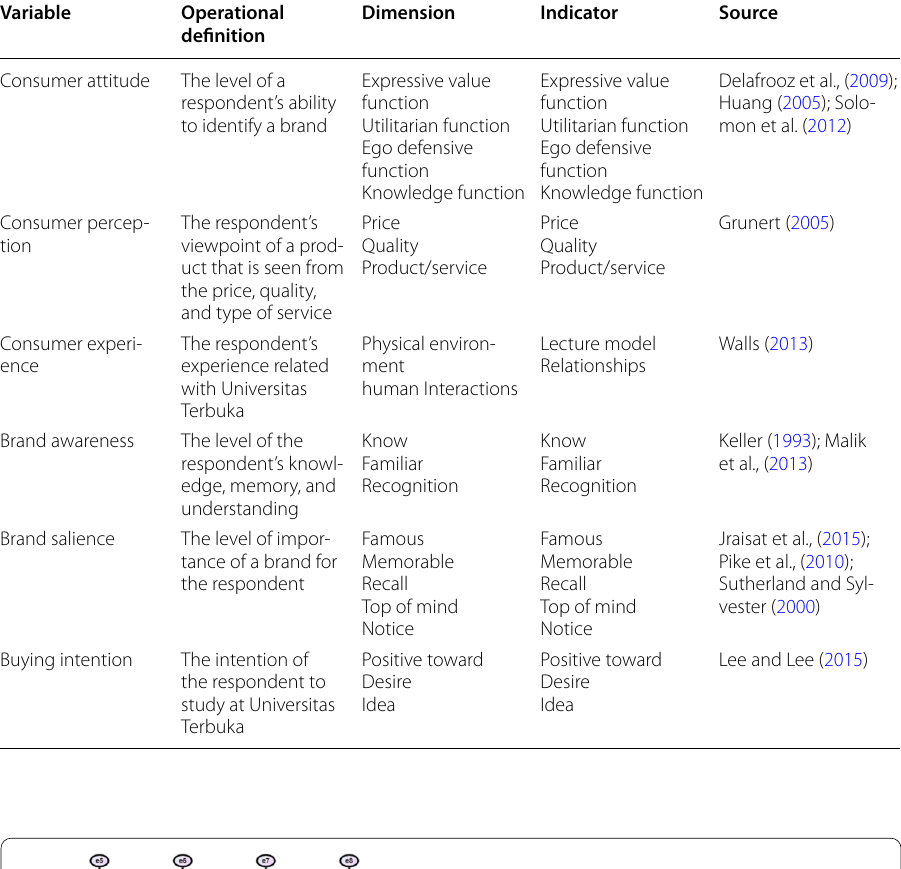
Table 1 Variables and operational